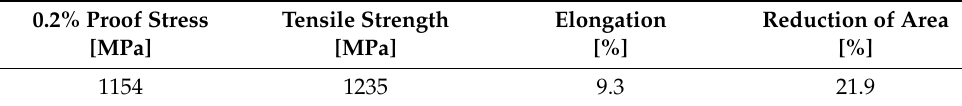
Table 2. Mechanical properties of the applied Ti-22V-4Al